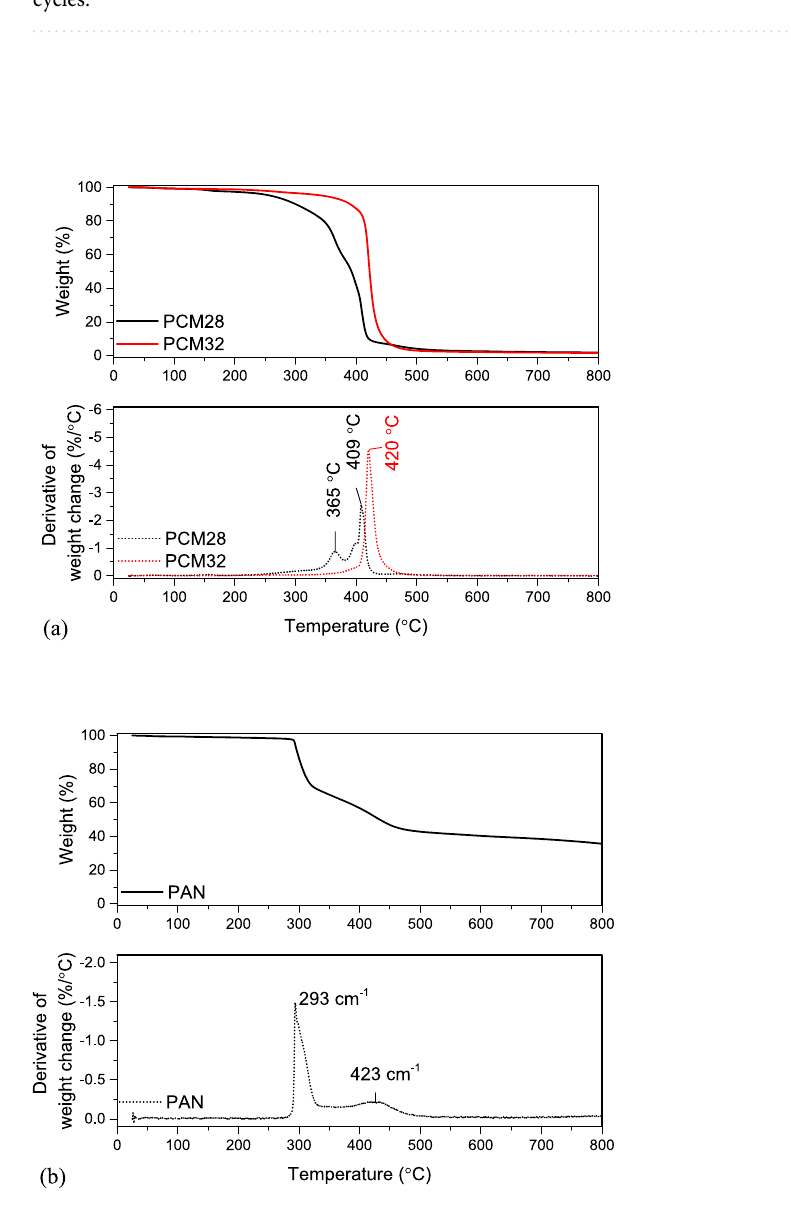
Figure 10. TGA and DTGA curves of ( a ) PCMs, ( b )